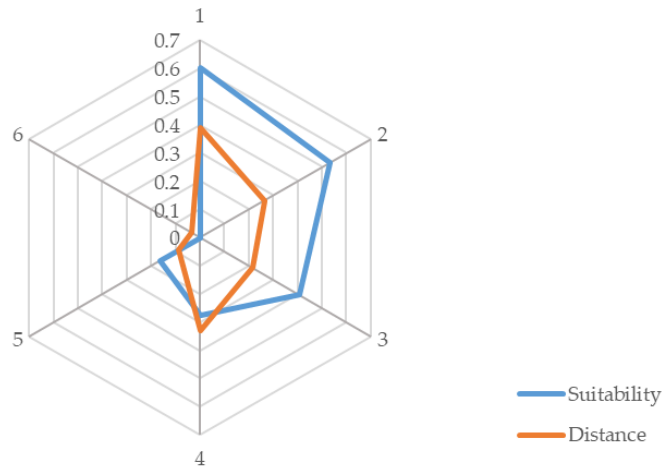
Figure 7. Deviation from the target value under different target weights. Under the balanced location–allocation scheme of the first stage, short-term emergency shelters can be planned. We need the upper bound of the objective function (Equation